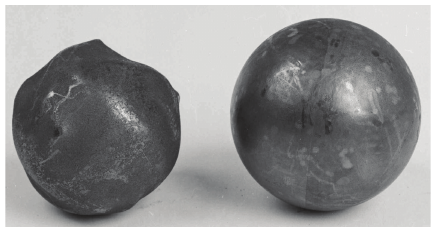
Figure 8: Oxidized and fresh fuel sphere